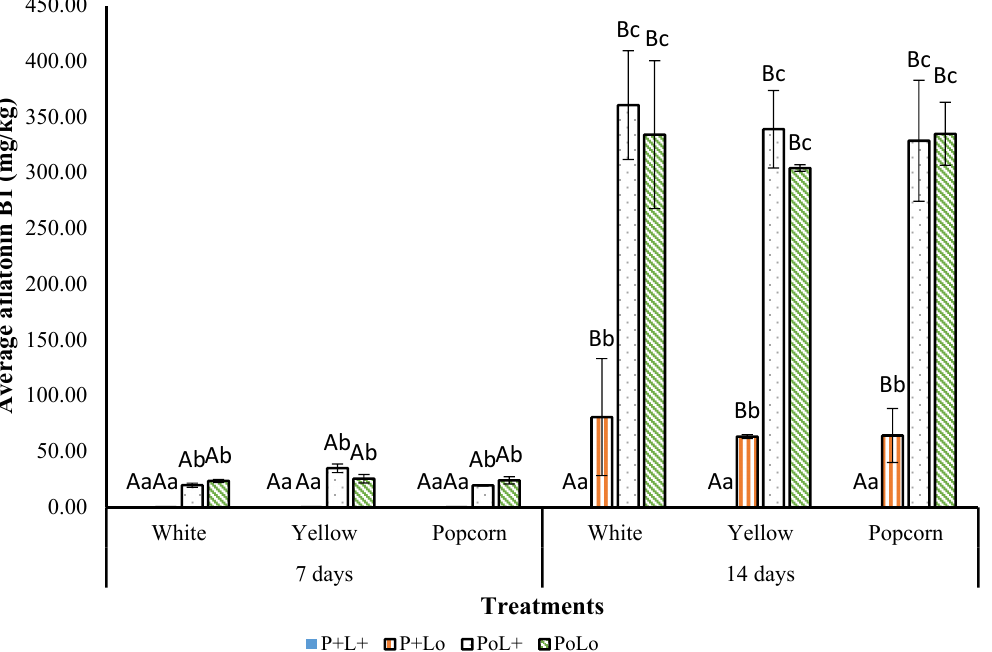
Figure 6. Concentration of aflatoxin B1 on maize kernel after photosensitization (P + L + ), photosensitizer (P + L + ), light (P o L + ) treatments and negative control (P o L o ). Data are means ± SE ( n = 3); means followed by different letters (lowercase letter for treatments in the same variety and uppercase letter for different periods in the same variety) are significantly different ( p < 0.05).